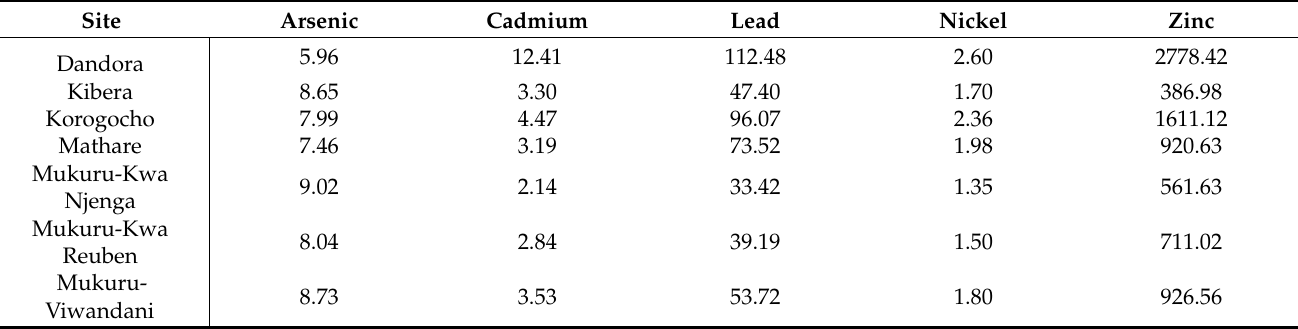
Table 2. Mukuru and Control Sites: Mean Soil Concentrations, Select Metals